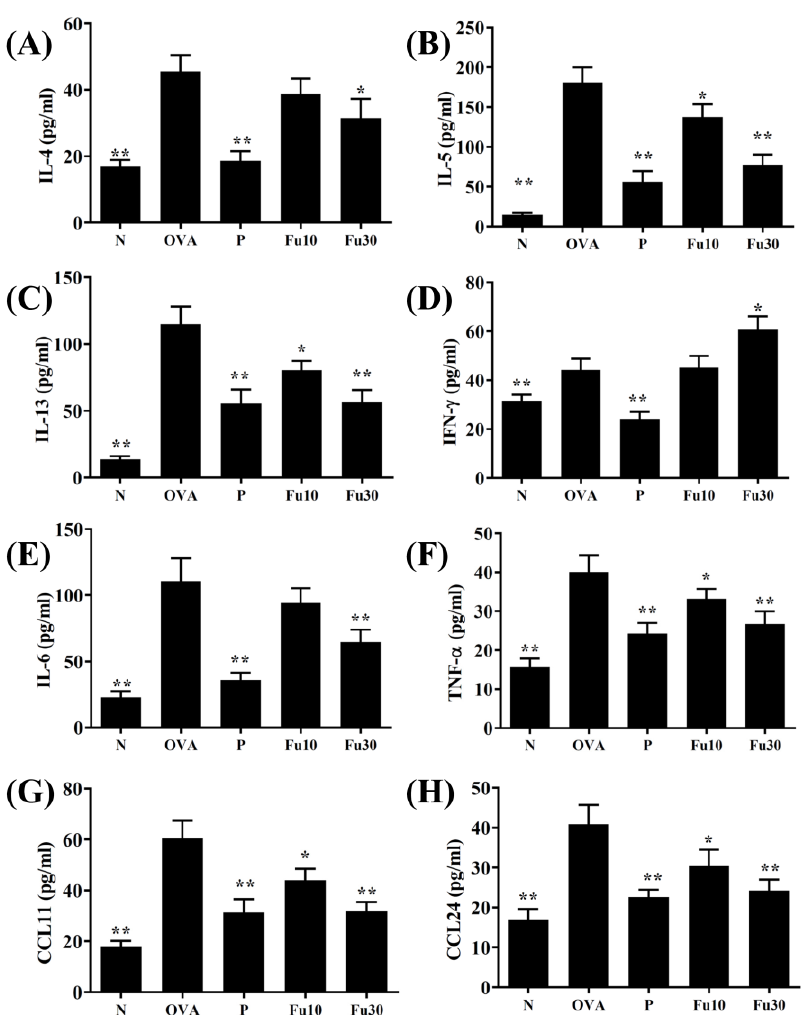
Figure 5. The effects of fucoxanthin (Fu) on the cytokine and chemokine levels in the BALF. ( A ) The concentrations of IL-4, ( B ) IL-5, ( C ) IL-13, ( D ) IFN- γ , ( E ) IL-6, ( F ) TNF- α , ( G ) CCL11, and ( H ) CCL24 were measured by ELISA using BALF from normal (N) and OVA-stimulated (OVA) mice with or without Fu (10 or 30 µ M) treatment. Three independent experiments were analyzed. Data are presented as mean ± SEM. * p < 0.05, ** p < 0.01 compared to the OVA control group. 10 mg/kg and 30 mg/kg fucoxanthin were named as Fu10 and Fu30, respectively. 5 mg/kg prednisolone was named as P.